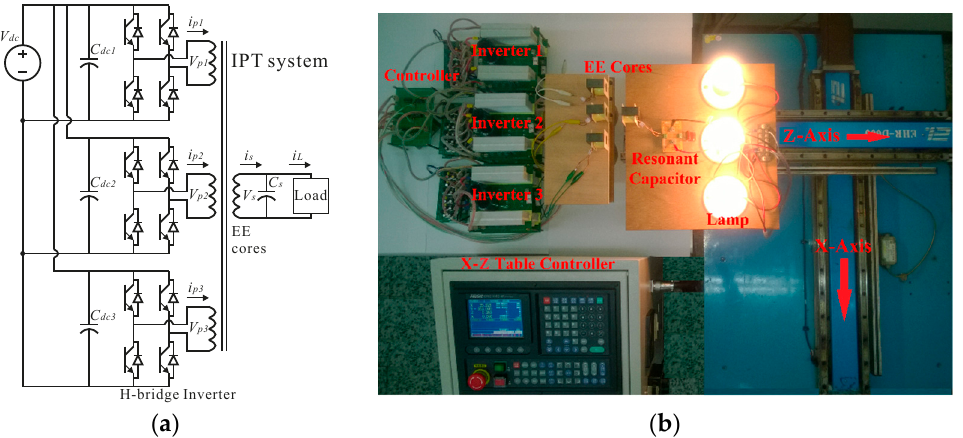
Figure 4. Prototype of measurement for the P topology IPT system. ( a ) multi ‐ H ‐ bridge inverters ( b ) prototype of measurement.